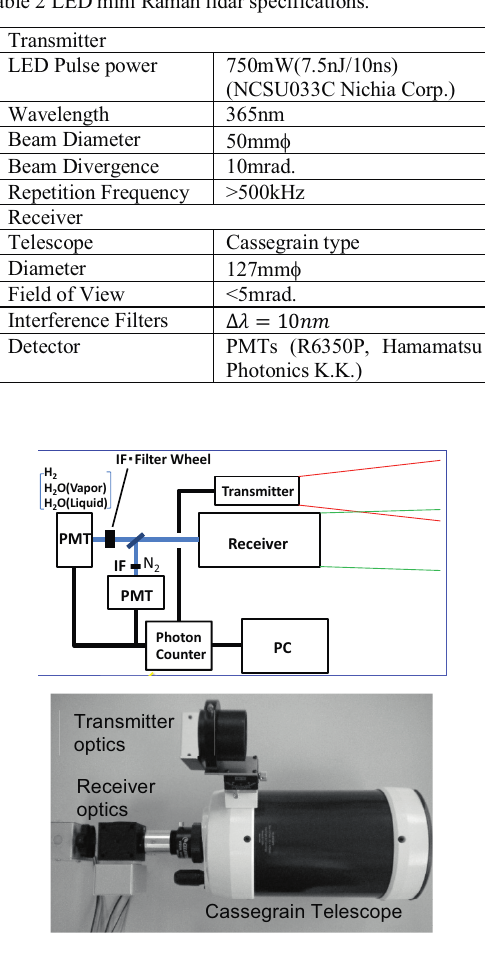
Fig. 1 Optical setup of LED mini Raman lidar.